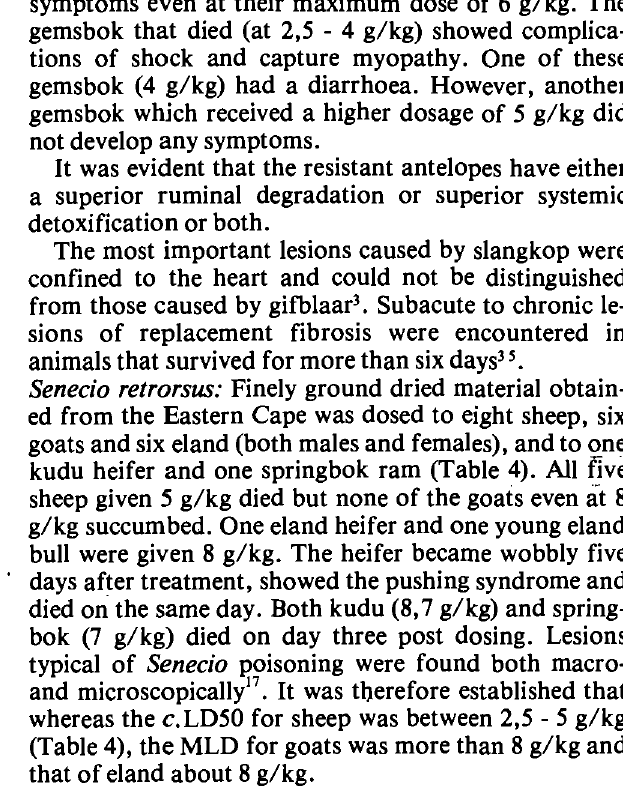
Table 2: Mortalities caused by D. cymosum Dosage No. of deaths/No. dosed